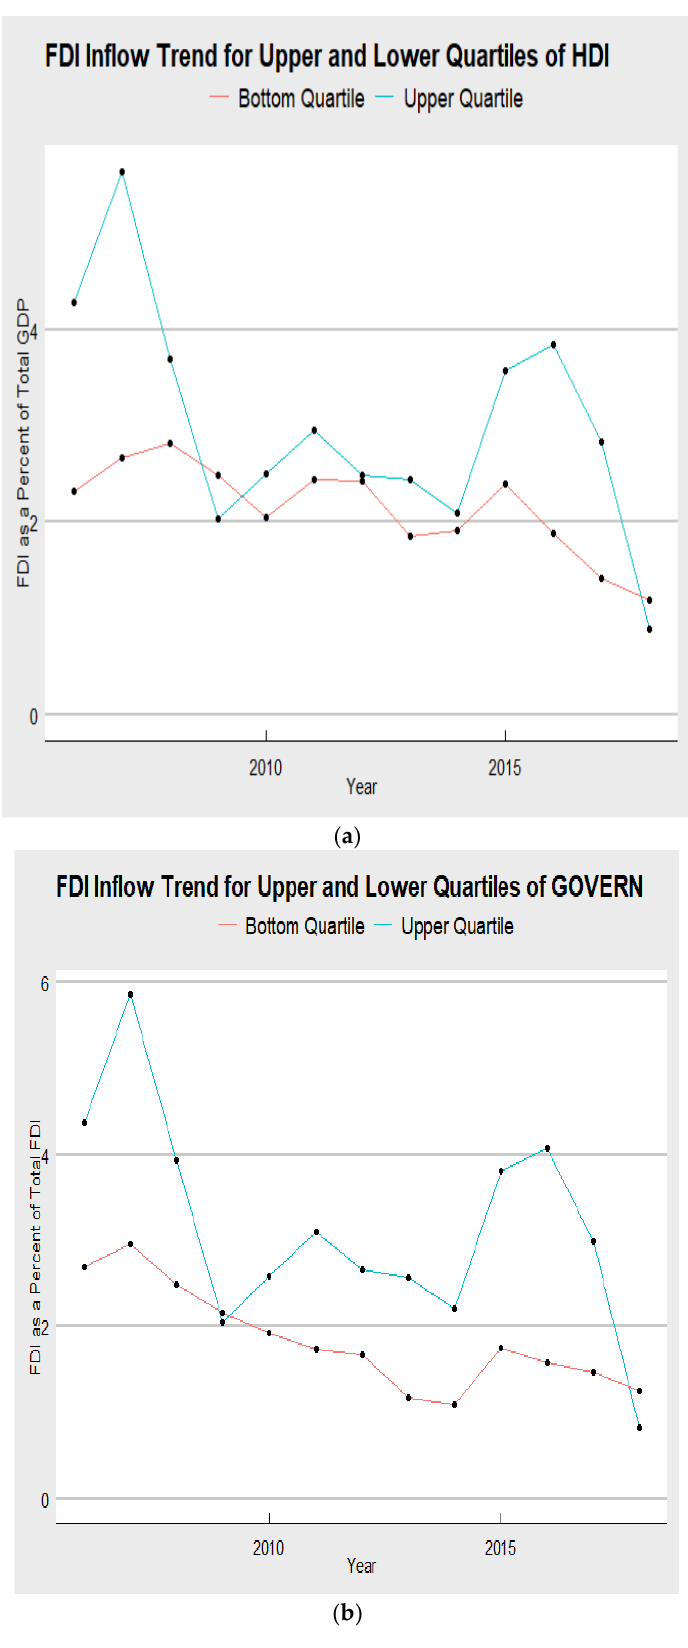
Figure 5. HDI and GOVERN and FDI inflows: ( a ) human development index (HDI); ( b ) governance